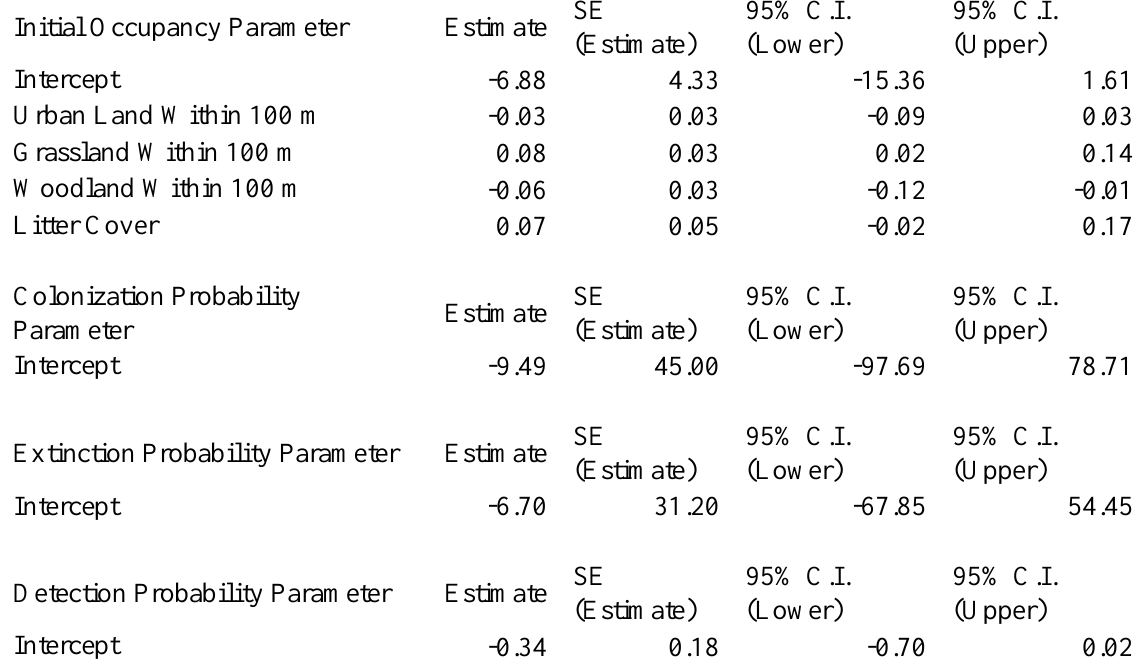
=257.99, ∆ AIC =2.09, c c